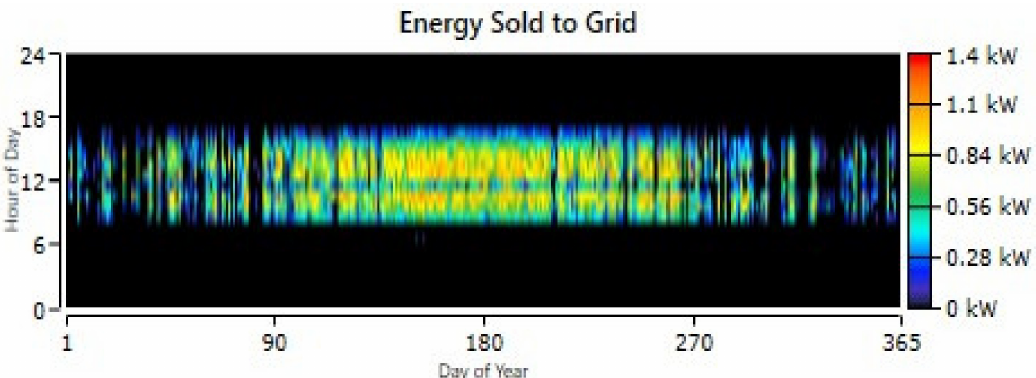
Figure 16. Daily electricity production in one year in